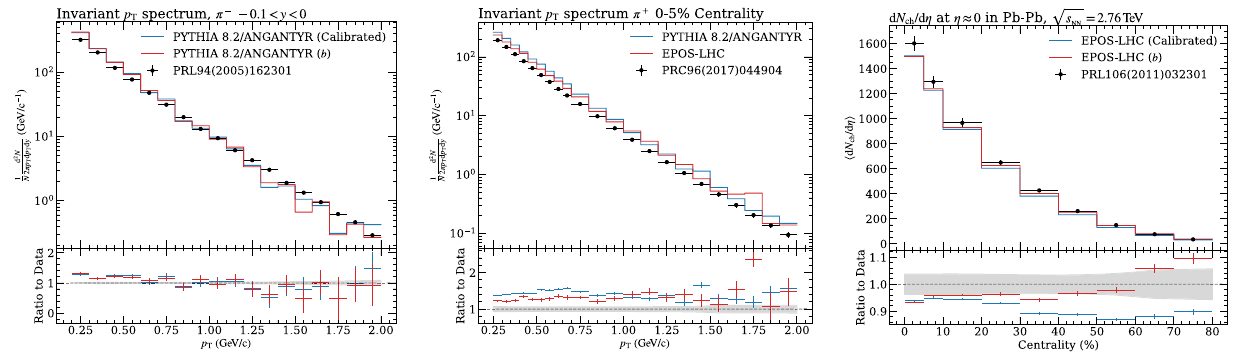
Fig. 6 Results from the analyses BRAHMS_2004_I647076 (left; invariant p T of π − in 0 < y < 0 . 1), STAR_2017_I151059 (middle; invariant p T for K + in | y | < 0 . 1) and ALICE_2010_I880049 (right; d N ch / d η vs. centrality) utilizing centrality